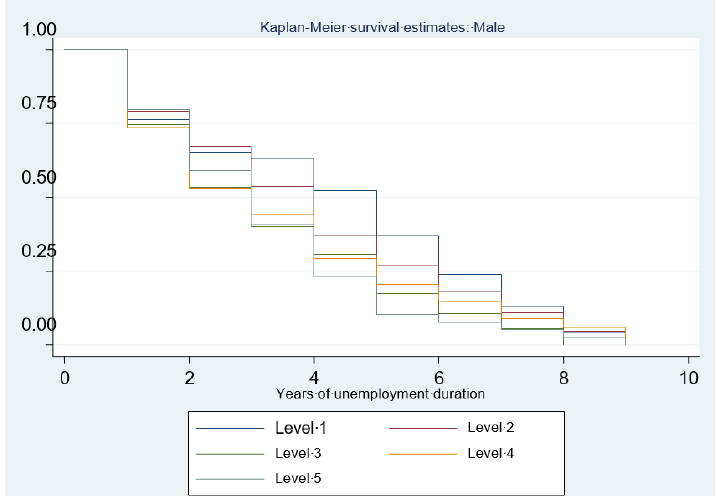
Figure 4: Survival function by gender and education